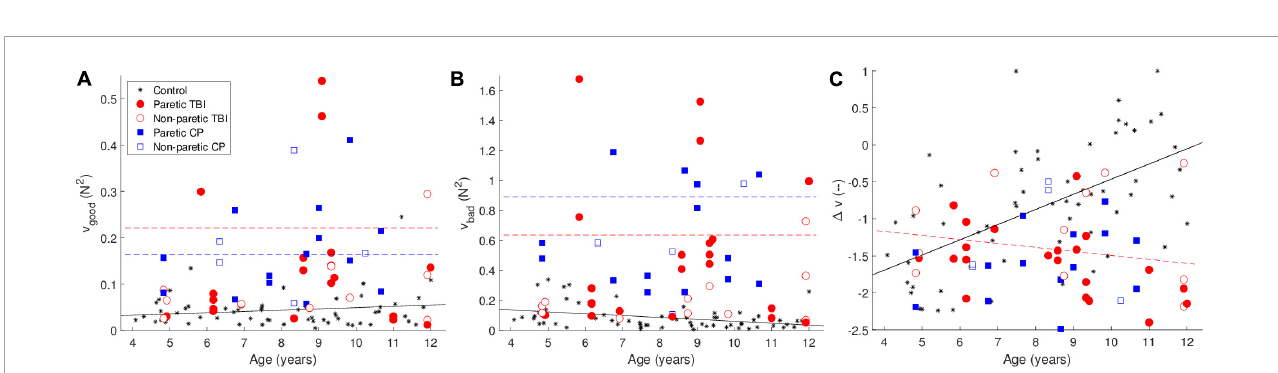
FIGURE2 Uncontrolled manifold (UCM) analysis— (A) shows the good variance (that which doesn’t affect the outcome variable) (B) shows the bad variance (which does affect the outcome variable). (C) Shows the synergy index (cid:49) v. The black line is the predicted data for the control group, the dashed red line is the predicted data for the TBI group, and the dashed red line is the predicted data for the CP group, according to the tested models. The lines are only drawn when the differences between the groups was significant. The color of the points indicates the group. The black stars are data from typically developing children from a previous